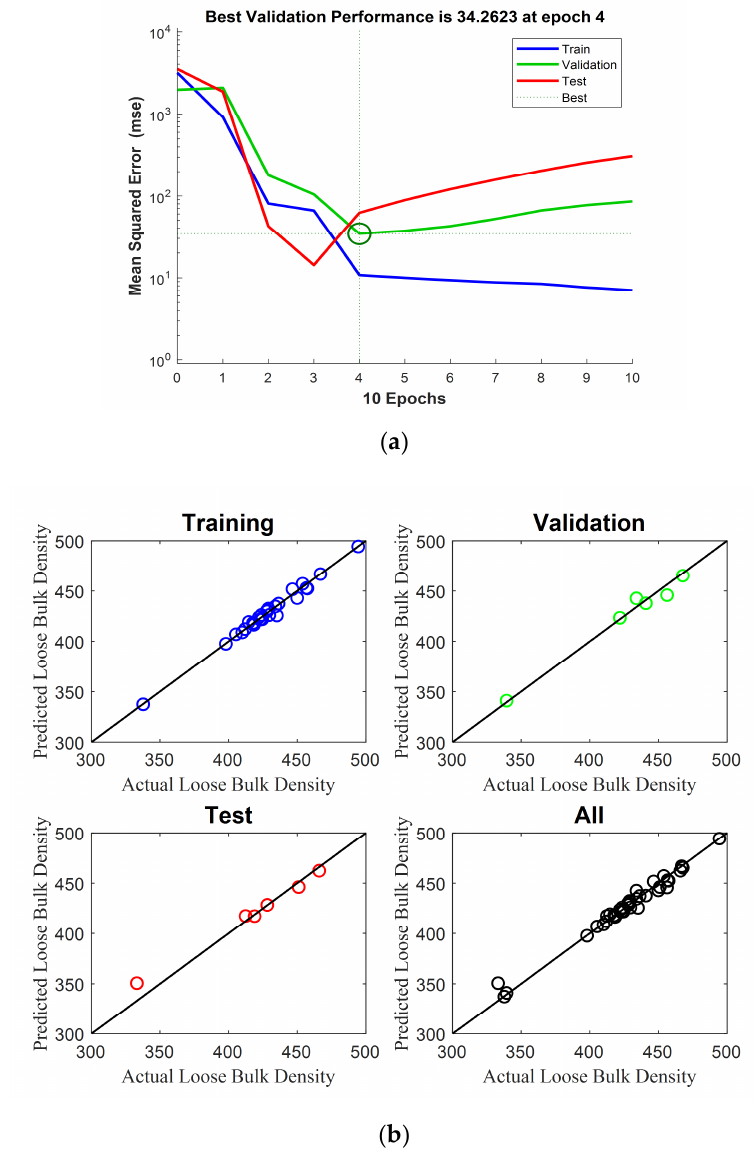
Figure 14. ( a ) Validation of the artificial neural networks (ANN) model of loose bulk density; ( b ) Performance of the ANN model of loose bulk density. Table 3. Results of the ANN model of loose bulk